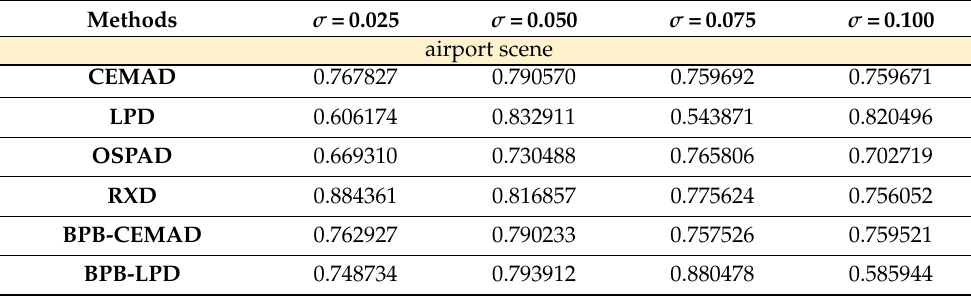
Table 3. The AUC ( D,F ) values of HSIs under different noise